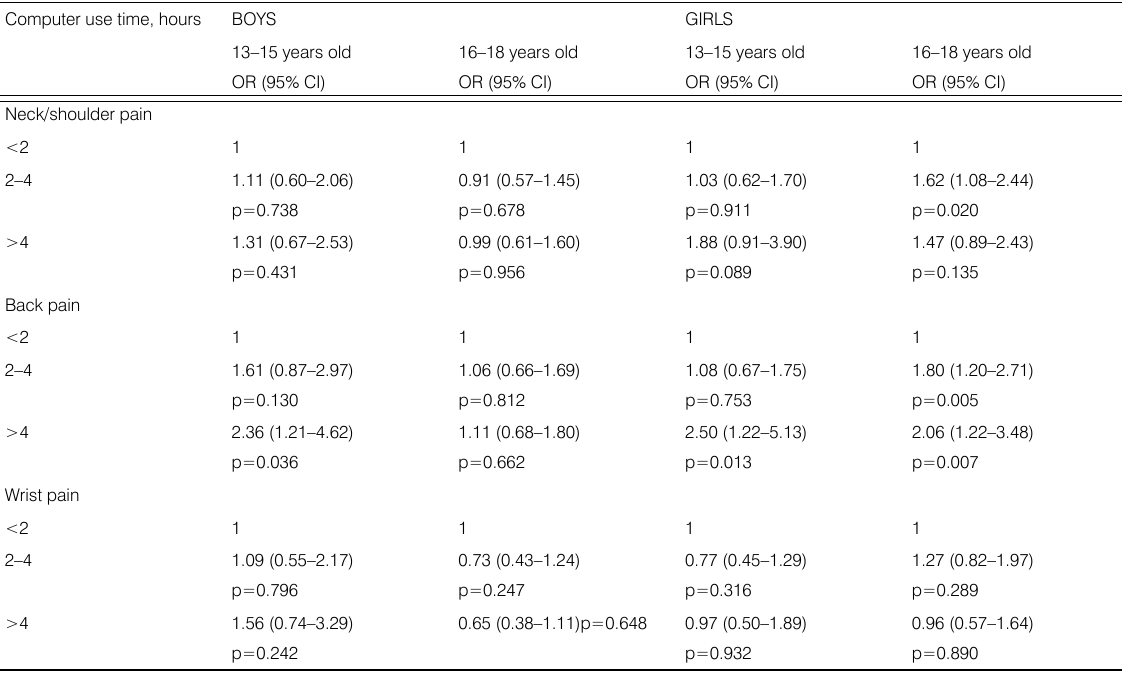
OR - odds ratio; CI - confidence